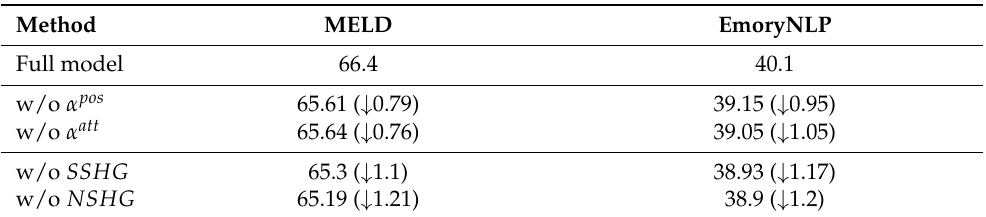
Table 4. Results of the ablation study. ’ ↓ ’ represents the reduced performance compared with the ’Full